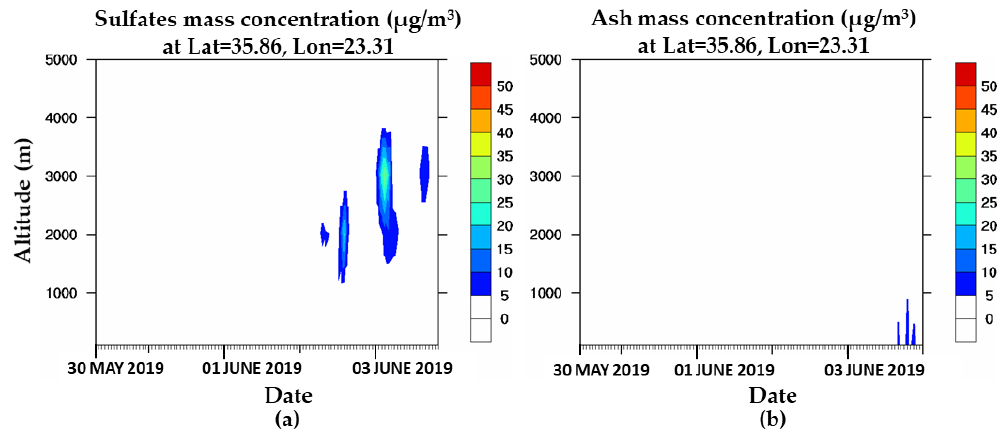
Figure 7. Modeled ( a ) sulfates and ( b ) ash concentration ( µ g/m 3 ) over Antikythera, from 30 May 10:00 UTC to 4 June, 00:00